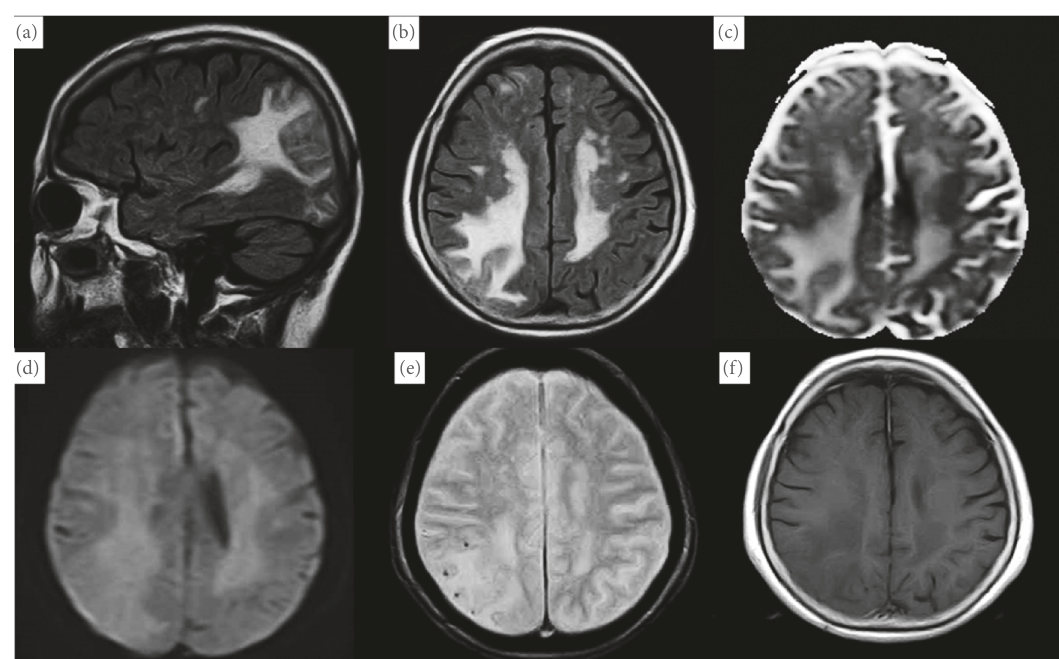
Figure1:Magneticresonanceimaging(MRI)showshypersignalintenselesionsinthesubcorticalwhitematterinthebilateralandasymmetric parietal lobe in both fluid-attenuated inversion recovery (FLAIR) sequence (a and b) and apparent diffusion coefficient (ADC; (c)); however, these lesions were not recognized in diffusion-weighted imaging (DWI; (d)). T2 ∗ -weighted gradient echo imaging reveals some subcortical microbleeds in the right parietal lobe (e). Postgadolinium T1-weighted images show no enhancement